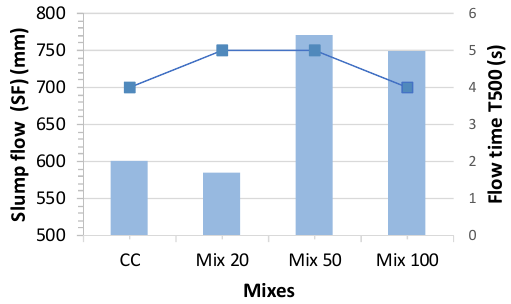
Figure 10. Slump flow time test results.